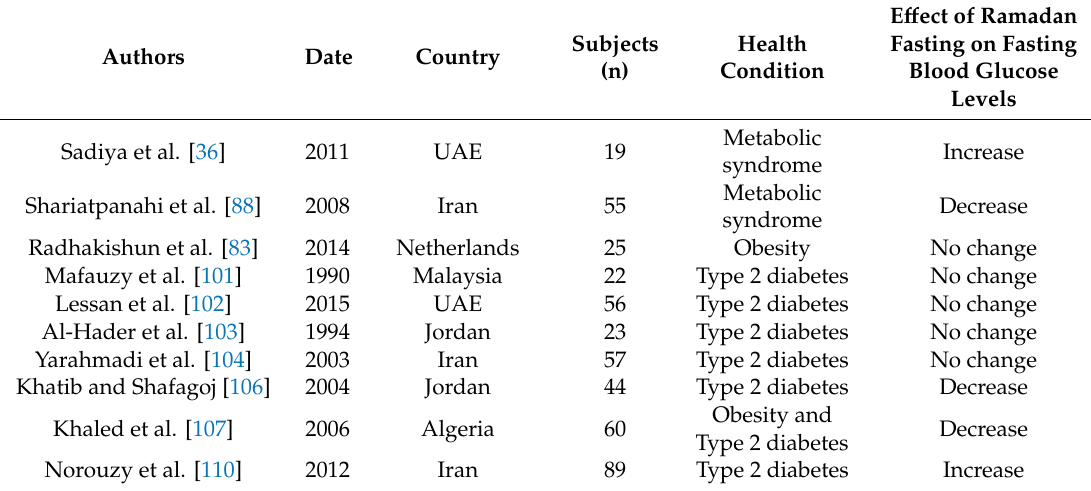
Table 6. E ff ect of Ramadan fasting on fasting blood glucose levels in subjects with health